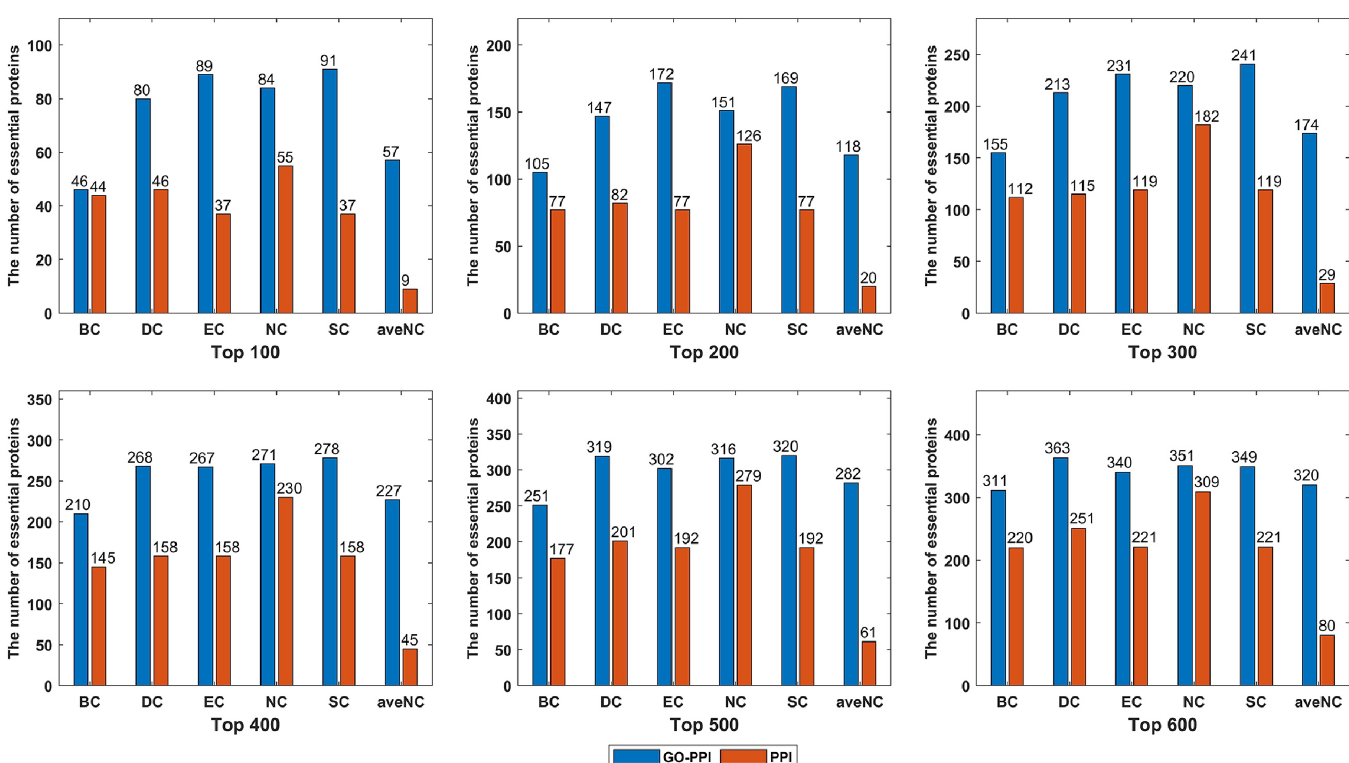
Fig 2. The numbers of key proteins predicted correctly under the original PPI network and reconstructed GO-PPI network for the YDIP dataset.